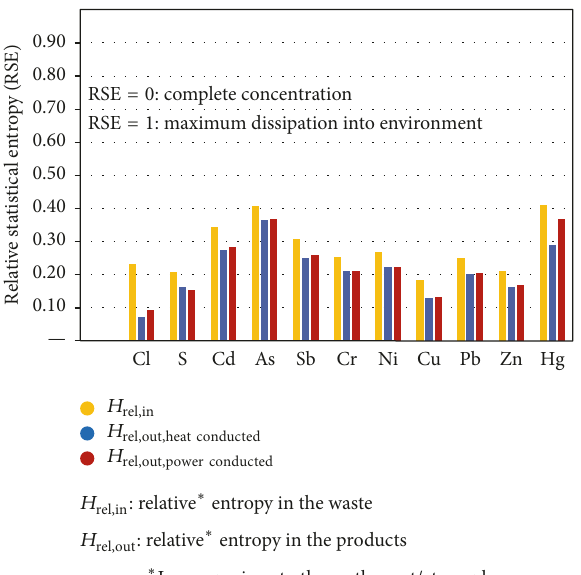
Figure 7: Statistical entropy analysis for chlorine, sulfur, and heavy metals for heat- and power-conducted WtE